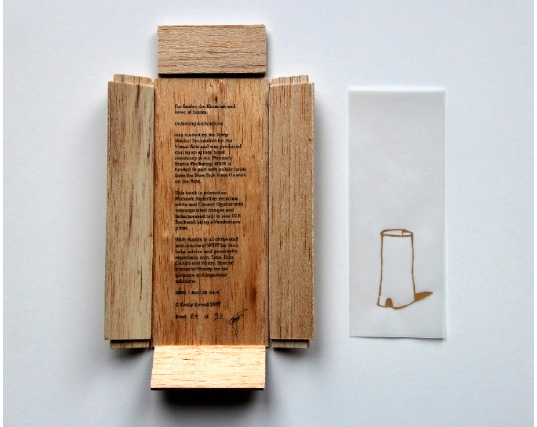
Figure 7. Unfolding Architecture case (2007) by Emily Speed. Photo by Elaine Speight. Used with permission.